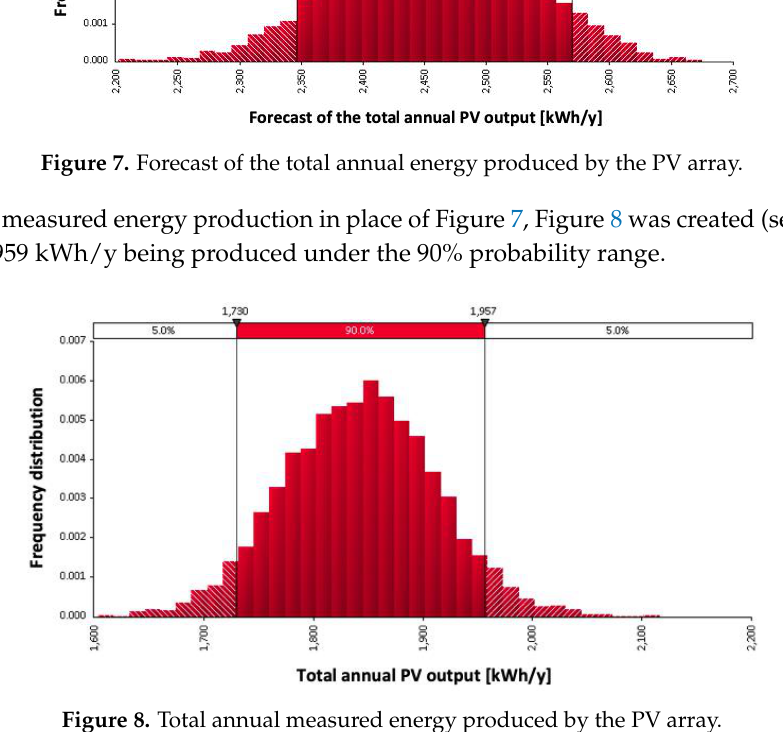
Table 3. Descriptive statistics of the total annual energy produced by the PV array (kWh/y).